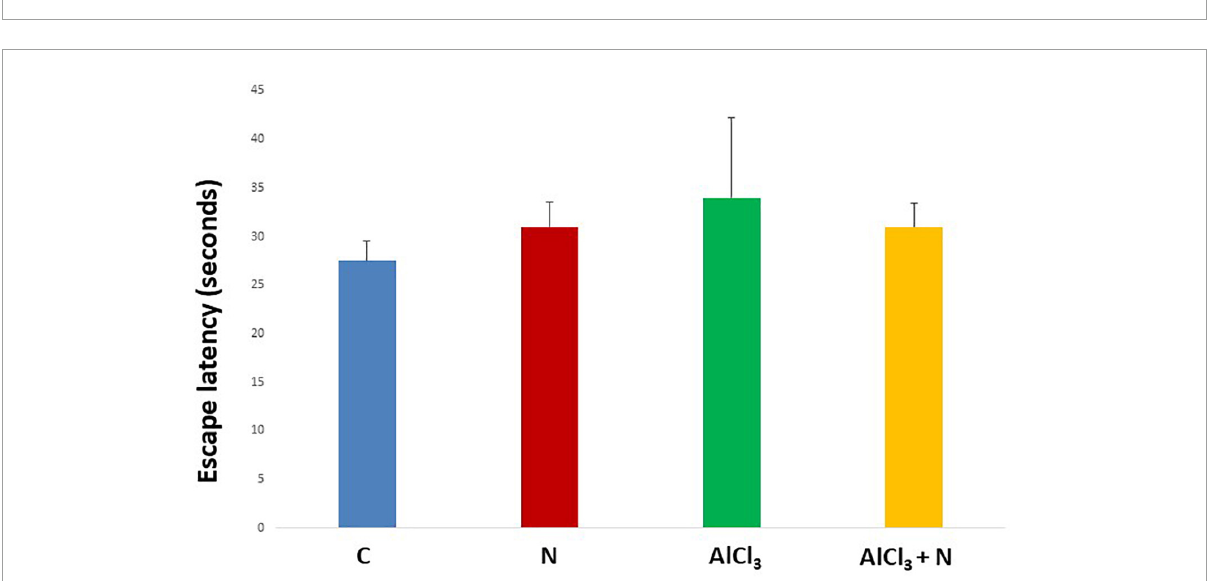
FIGURE1 Grip period in the Rotarod test during initial training periods in the studied groups. n = 6 in each group. Data were prescribed as mean ± SD . No significant differences were detected between any groups ( p > 0.05, Games-Howell post-hoc test).